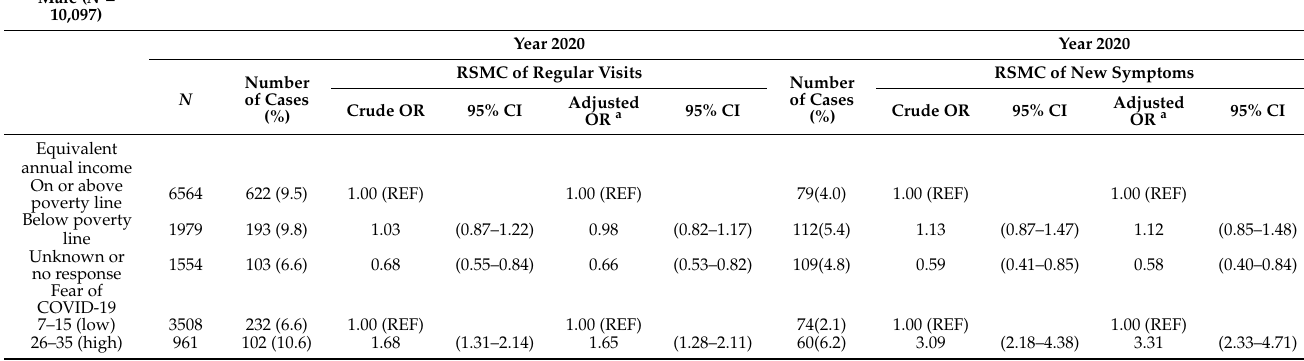
Table A1. Odds ratios (ORs) of household income for refraining from seeking medical care (RSMC) of regular visits and symptoms in